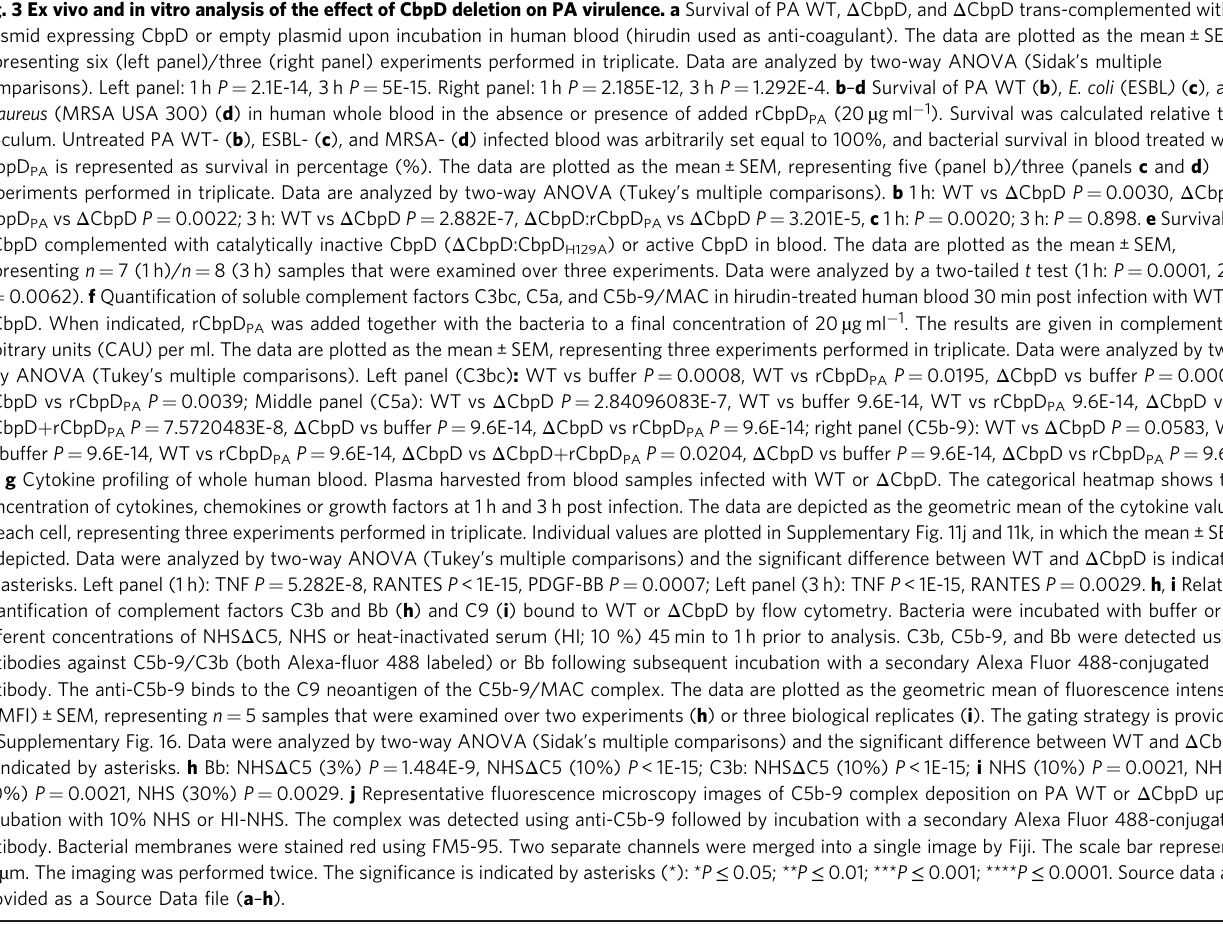
Fig. 3 Ex vivo and in vitro analysis of the effect of CbpD deletion on PA virulence. a Survival of PA WT, Δ CbpD, and Δ CbpD trans-complemented with a plasmid expressing CbpD or empty plasmid upon incubation in human blood (hirudin used as anti-coagulant). The data are plotted as the mean ± SEM, representing six (left panel)/three (right panel) experiments performed in triplicate. Data are analyzed by two-way ANOVA (Sidak ’ s multiple comparisons). Left panel: 1 h P = 2.1E-14, 3 h P = 5E-15. Right panel: 1 h P = 2.185E-12, 3 h P = 1.292E-4. b – d Survival of PA WT ( b ), E. coli (ESBL ) ( c ), and S. aureus (MRSA USA 300) ( d ) in human whole blood in the absence or presence of added rCbpD PA (20 µ g ml − 1 ). Survival was calculated relative to inoculum. Untreated PA WT- ( b ), ESBL- ( c ), and MRSA- ( d ) infected blood was arbitrarily set equal to 100%, and bacterial survival in blood treated with rCbpD PA is represented as survival in percentage (%). The data are plotted as the mean ± SEM, representing fi ve (panel b)/three (panels c and d ) experiments performed in triplicate. Data are analyzed by two-way ANOVA (Tukey ’ s multiple comparisons). b 1 h: WT vs Δ CbpD P = 0.0030, Δ CbpD: rCbpD PA vs Δ CbpD P = 0.0022; 3 h: WT vs Δ CbpD P = 2.882E-7, Δ CbpD:rCbpD PA vs Δ CbpD P = 3.201E-5, c 1 h: P = 0.0020; 3 h: P = 0.898. e Survival of Δ CbpD complemented with catalytically inactive CbpD ( Δ CbpD:CbpD H129A ) or active CbpD in blood. The data are plotted as the mean ± SEM, representing n = 7 (1 h)/ n = 8 (3 h) samples that were examined over three experiments. Data were analyzed by a two-tailed t test (1 h: P = 0.0001, 2 h: P = 0.0062). f Quanti fi cation of soluble complement factors C3bc, C5a, and C5b-9/MAC in hirudin-treated human blood 30 min post infection with WT or Δ CbpD. When indicated, rCbpD fi nal concentration of 20 µ g ml − 1 . The results are given in complement PA was added together with the bacteria to a arbitrary units (CAU) per ml. The data are plotted as the mean ± SEM, representing three experiments performed in triplicate. Data were analyzed by two-